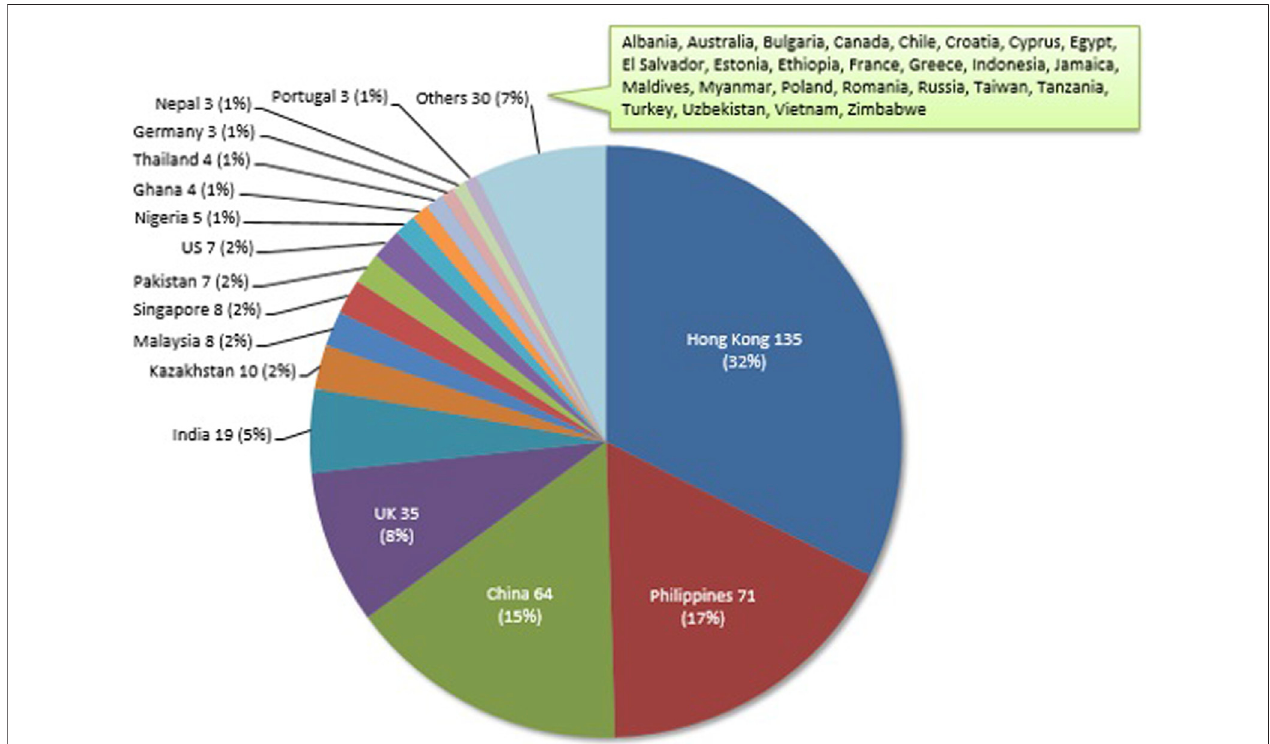
FIGURE 2 | Home region of student participation (second eTournament) ( N (cid:1)